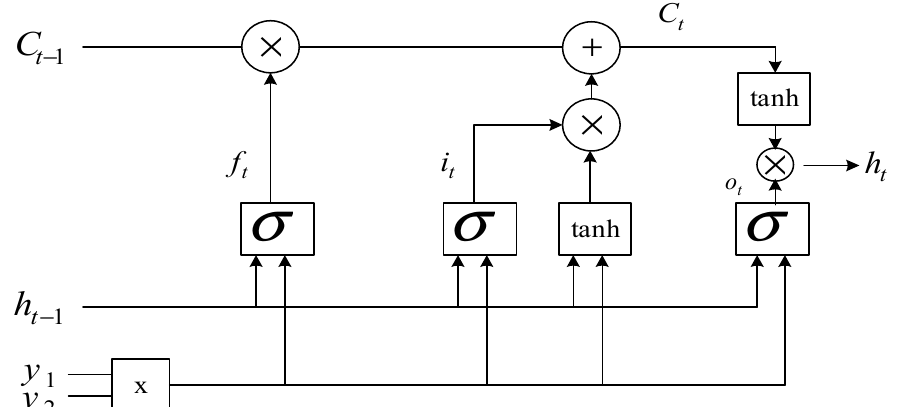
Figure 5. Standard LSTM structure.